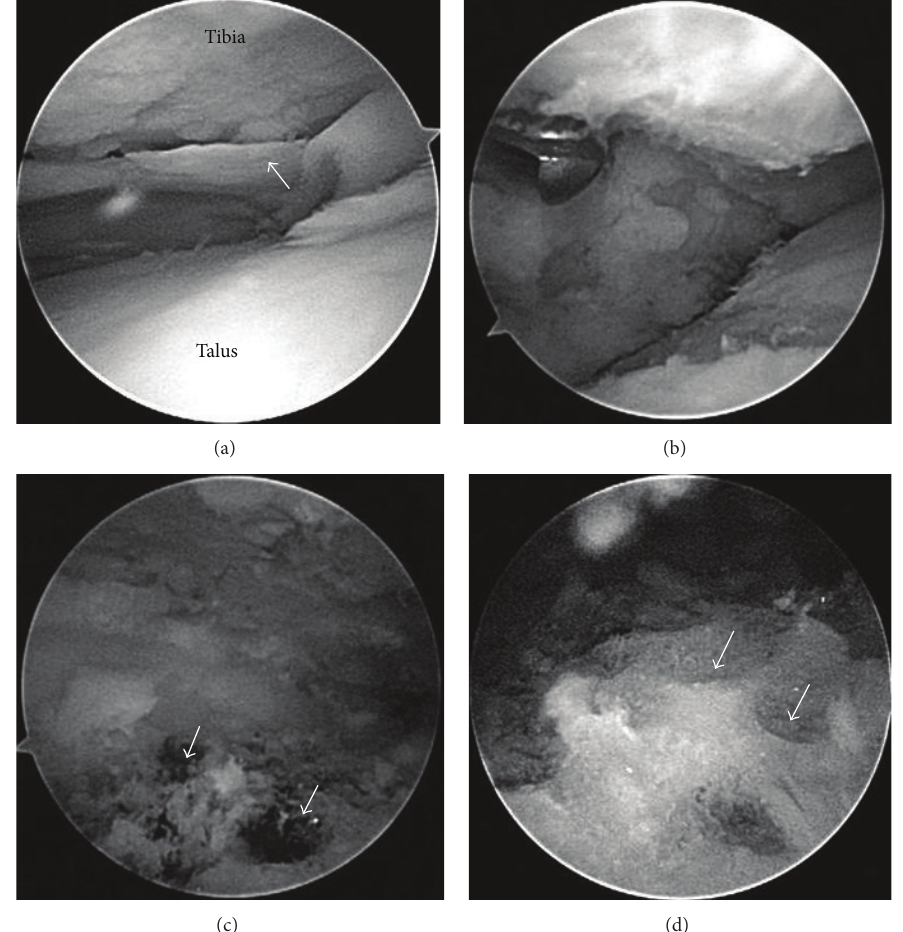
Figure 3: Intraoperative findings. (a) Arrow shows peeled cartilage from tibia. (b) The observed cartilage is removed using a shaver. (c) Arrows show bleeding from the dimple. (d) Arrows show numerous dimples on the